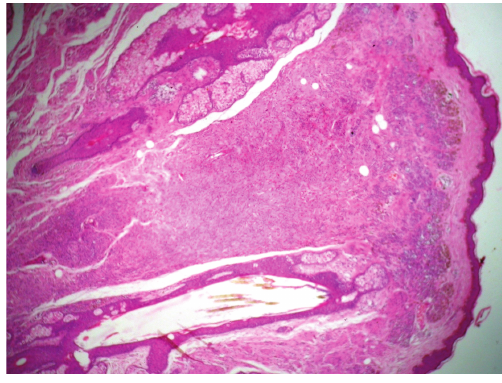
Figure 1: Nests of nevus cells with overlying normal epidermis (H&E, 10x).